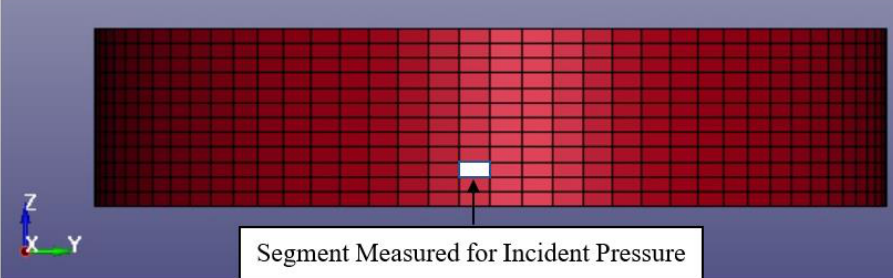
Figure 7. Typical segment of the tank where incident pressure is measured.